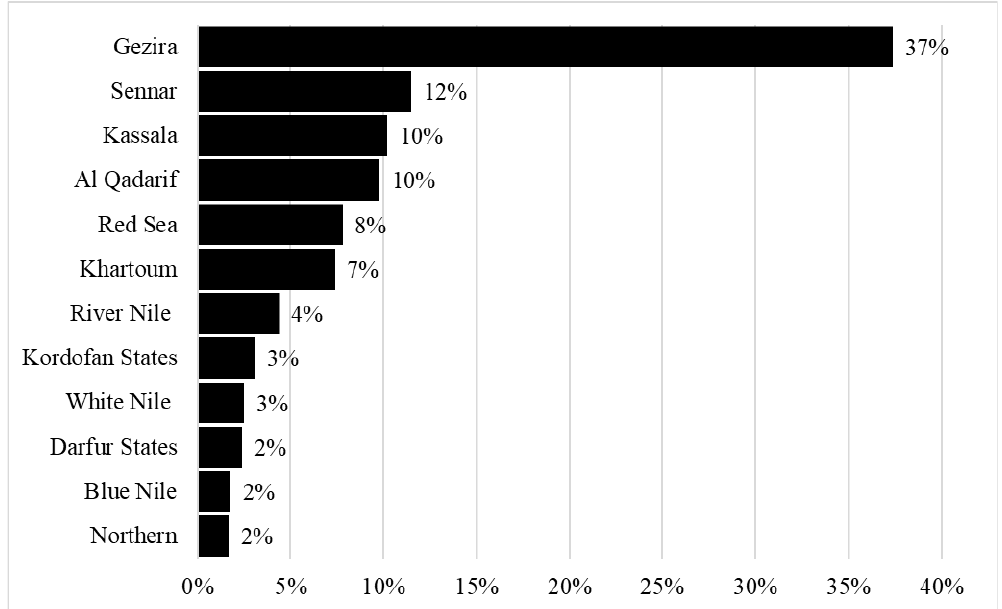
Figure 2. Distribution of subjects based on their state of residence.